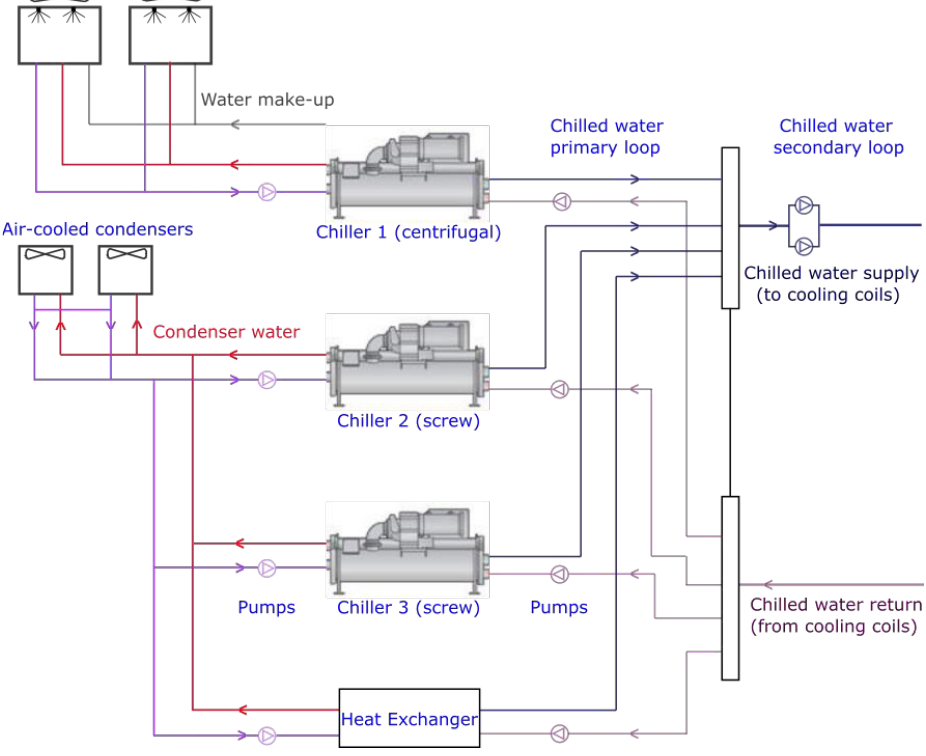
Figure 1. Schematic of the chilled water system in the large commercial case study building.